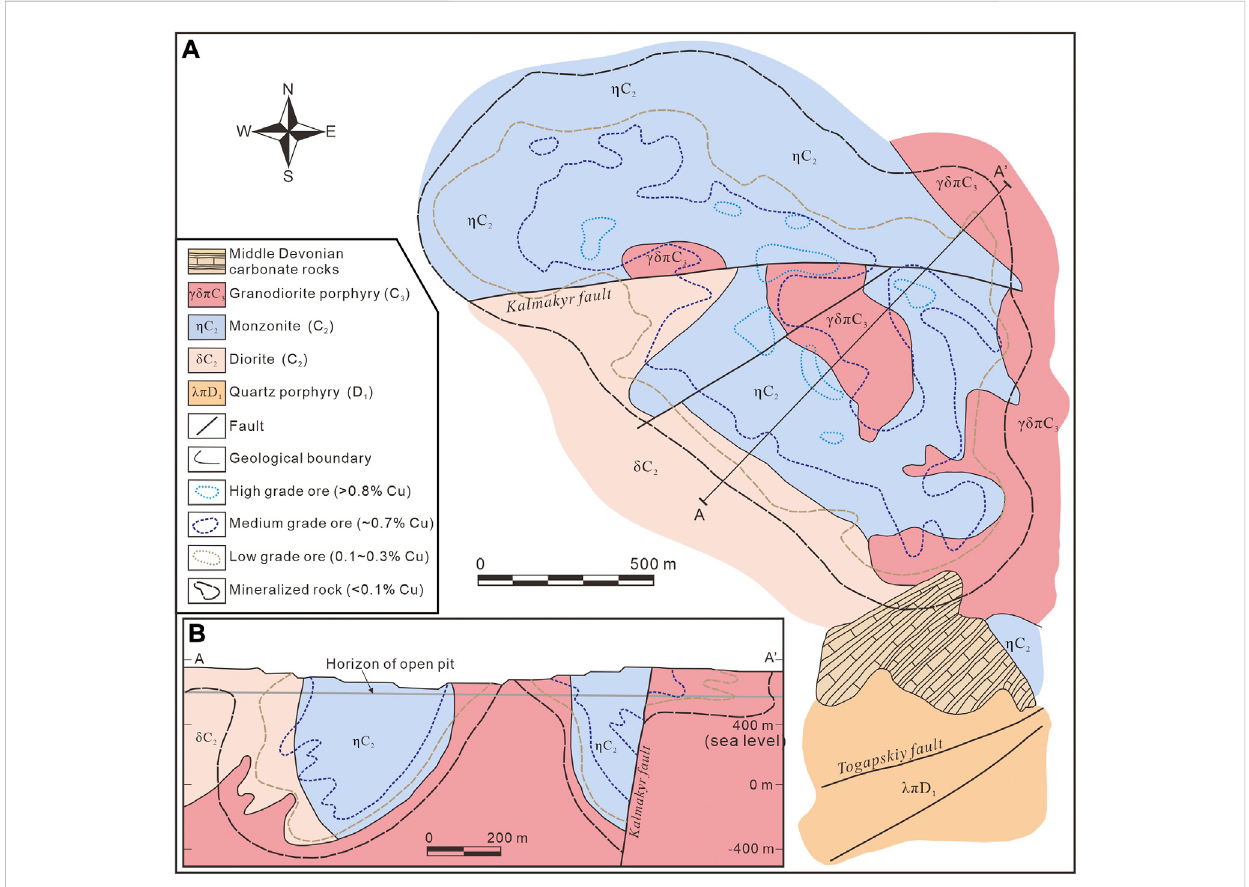
FIGURE 2 (A) Simpli fi edgeologicalmap;and (B) CrosssectionoftheKalmakyrgiantporphyryCu-Audeposit[modi fi edfrom(Golovanovetal.,2005)and(Zhao et al.,